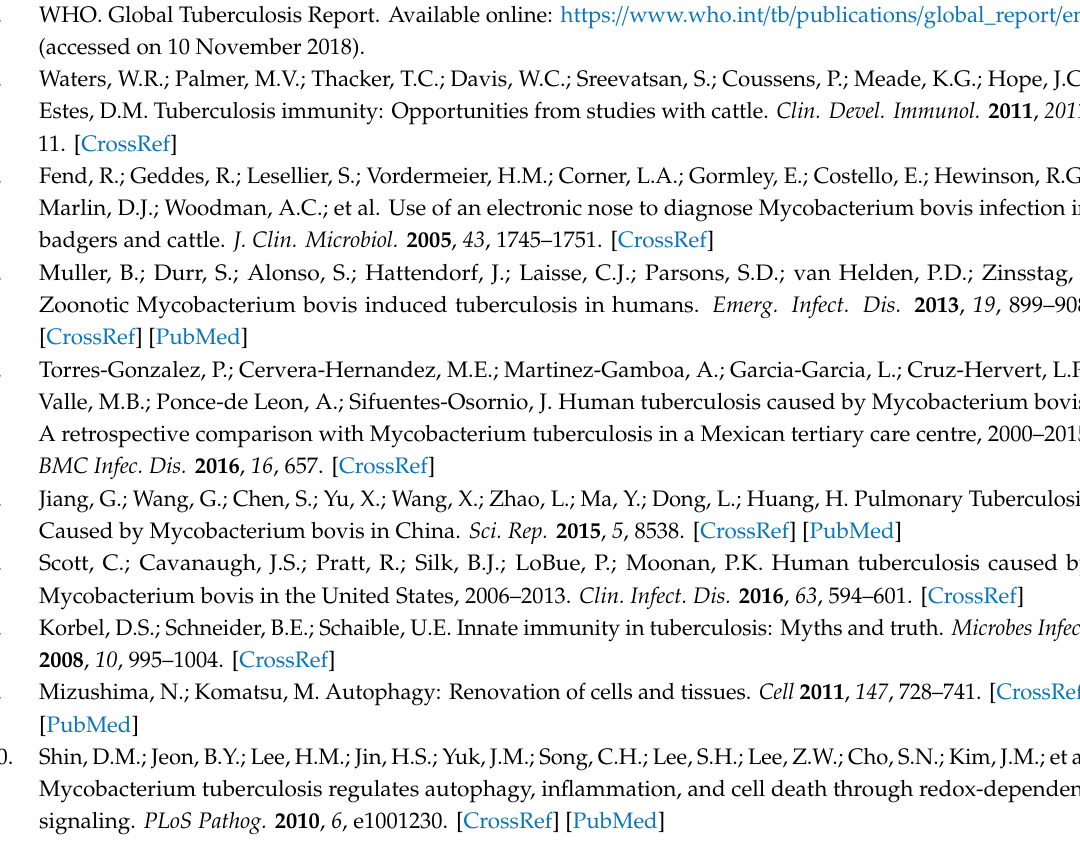
Figure S1: Examination of transfection e ffi cacy, Figure S2: Evaluation of phagocytic ability of BMDMs after transfection Figure S3: Assessment of cell viability, Table S1: Sense- and antisense sequences of KLK12 siRNA, negative control siRNA and FAM negative control